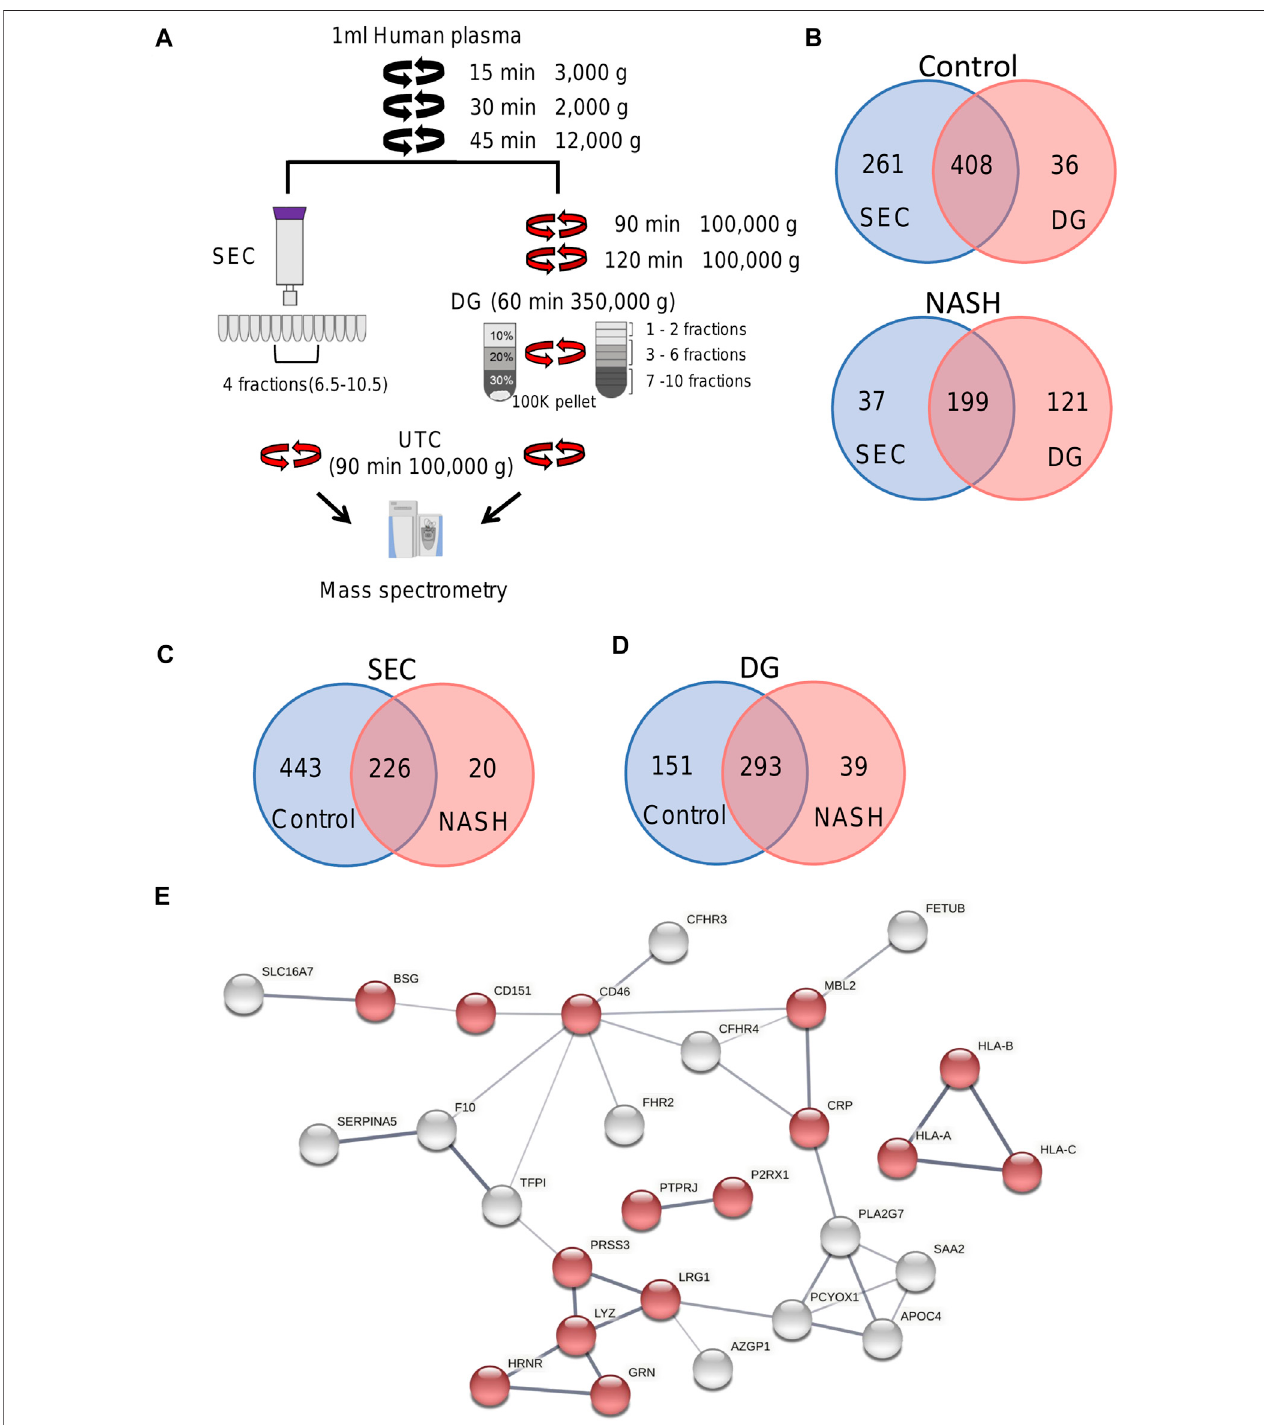
FIGURE 6| Overview ofplasma EV proteomics methods. (A) Schema represents two different EV isolation methods. In SEC, fractions 6.5 to10.5 were combined and pelleted by UTC. For DG fractions 1 – 2, 3 – 6, and 7 – 10 were collected and combined. (B) Venn diagram depicting the number of common and unique proteins in controlandNASHplasmaEVsisolatedbySECcomparedtoDGfractions3 – 6. (C) Venndiagramdepictingthenumberofcommonanduniqueproteinsincontrolplasma EVs isolated by SEC and NASH plasma EVs isolated by SEC. (D) Venn diagram depicting the number of common and unique proteins in control plasma EVs isolatedbyDGfractions3 – 6and NASHplasmaEVsisolatedbyDGfractions3 – 6. (E) Protein – protein interactionanalysiswasperformedbySTRINGsoftwareonunique NASHEVproteins;theedgesindicatebothfunctionalandphysicalproteinassociations;linethicknessindicatesthestrengthofdatasupport;weusedminimumrequired interaction score with medium con fi dence (0.400); disconnected nodes in the network were excluded; red color represents immune system process. The annotation of these proteins was done by using Gene Ontology.